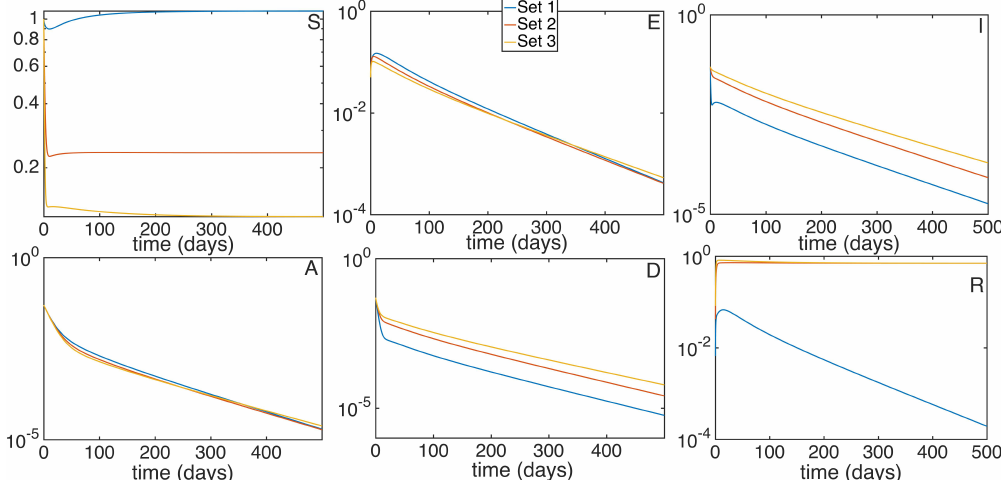
Figure 7. Time evolution of the different subpopulations given a R 0 = 0.81 and three different sets of control vaccination gains. Set 1 shares common parameters with set 2 and 3, except for K V = 0 and K ξ = 1.29, while set 2 presents K V = 0.45 and K ξ = 0.14 and set 3 K V = 0.90 and K ξ =